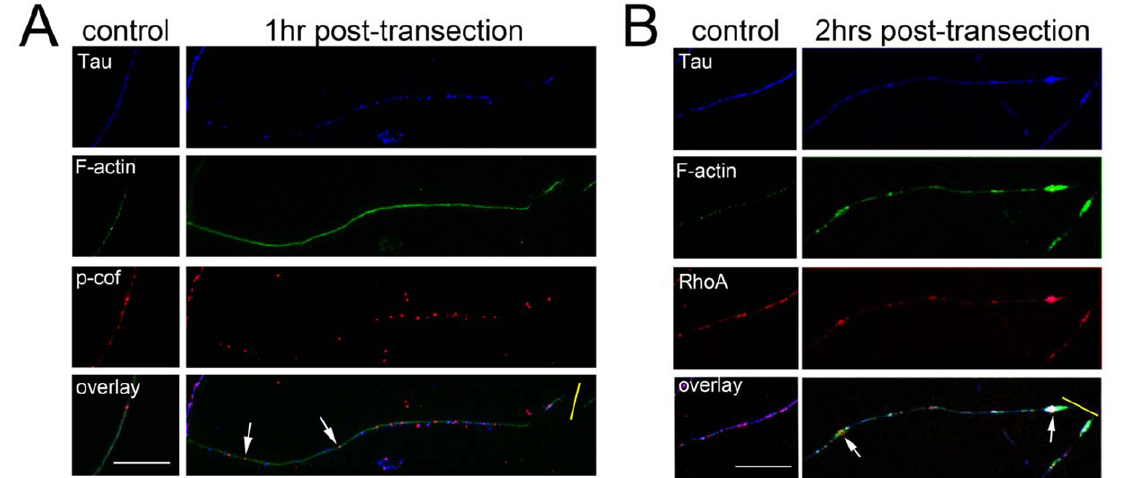
Figure 4. RhoA, phosphorylated cofilin and filamentous actin (F-actin) are modulated in injured axons invitro . Primary hippocampal neurons (14DIV) were cultured according to the method of Fath et al (2009) and stained for Tau, RhoA, p-cofilin, and F-actin at 1–2 hrs following transection of their neurites. Uninjured axons revealed amorphous puncta for RhoA, p-cofilin and F-actin that were distributed stochastically with a variable degree of co-localisation (A&B control panels). One hour following transection (yellow bar) F-actin staining appeared smooth and more intense with a concomitant redistribution of p-cofilin into widely-spaced circular puncta as indicated with arrows (A). After 2 hrs following transection, RhoA was observed to be concentrated in F-actin rich structures (B); in particular, large RhoA-positive swellings were observed (arrows), which also occasionally presented as enriched in tau (B). Scale bar=10 m M.